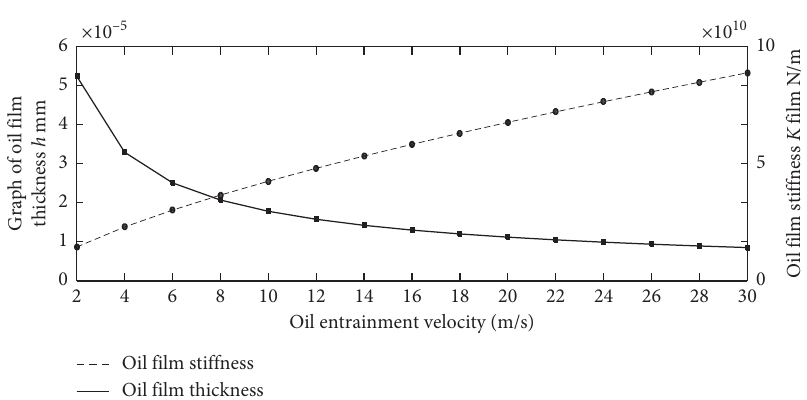
Figure 9: Changes of oil film thickness and stiffness under different entrainment